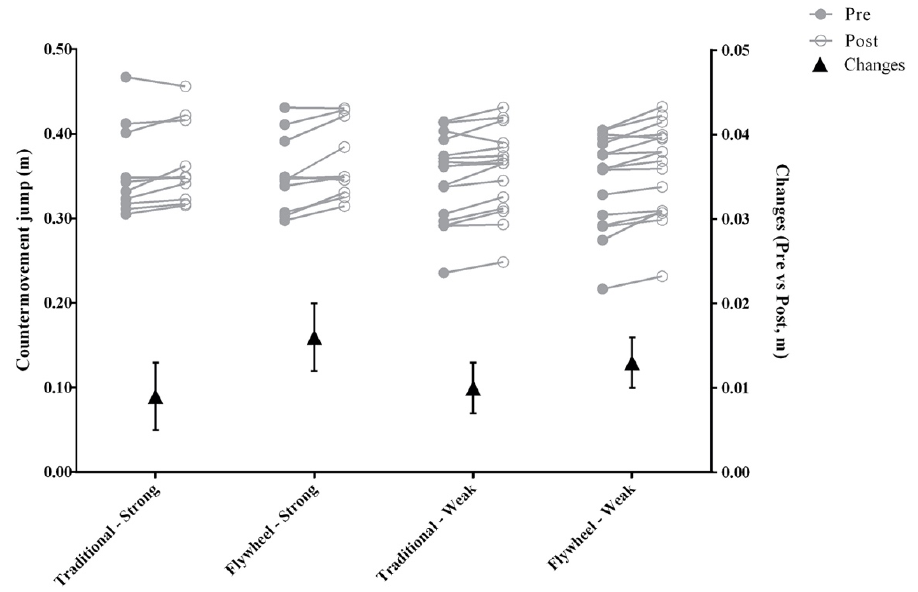
Figure 3. Group condition and individual trend changes from pre to post in countermovement jump (CMJ). Grey lines represent individual trend changes. Triangle marker represents mean ± standard error group changes.